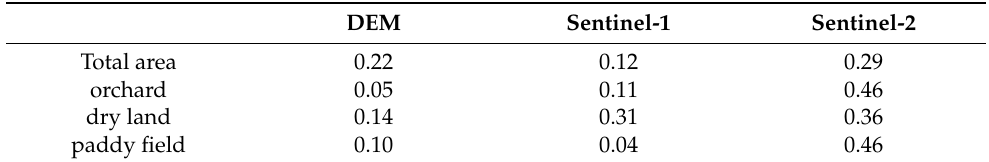
Table A2. The prediction accuracy (R 2 ) of XGboost based on purely DEM, purely Sentinel-1, and purely Sentinel-2 under total area, orchard, dry land, and paddy field.